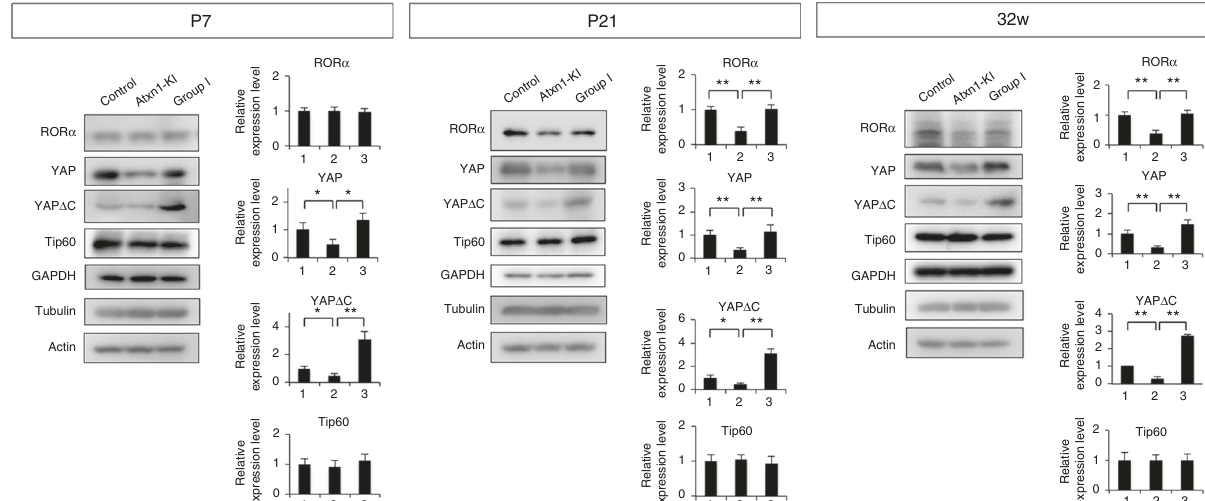
Fig. 8 Expression of YAP, YAPdeltaC, and ROR α in cerebellar cortex in vivo. Western blot analyses were performed with cerebellar cortex tissues to evaluate the protein levels of ROR α , YAP, YAPdeltaC, Tip60, GAPDH, tubulin, or actin in three groups of mice at P7, P21, and 32 weeks. Band intensities were normalized against GAPDH, as summarized in the right graphs. One-way ANOVA with post hoc Tukey ’ s HSD test was used for statistical analysis. ** p < 0.01, N =